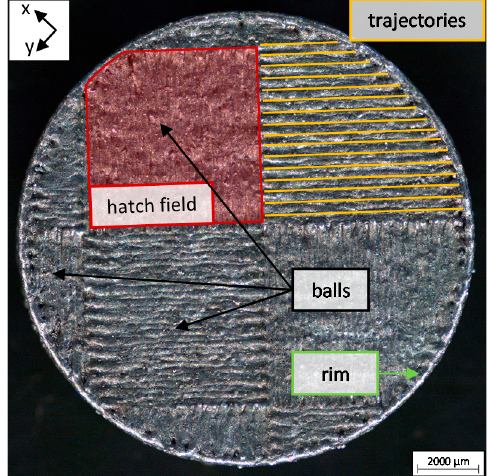
Figure 2. Top view of an additively manufactured sample (without re-melting of the last layers), which was used for the